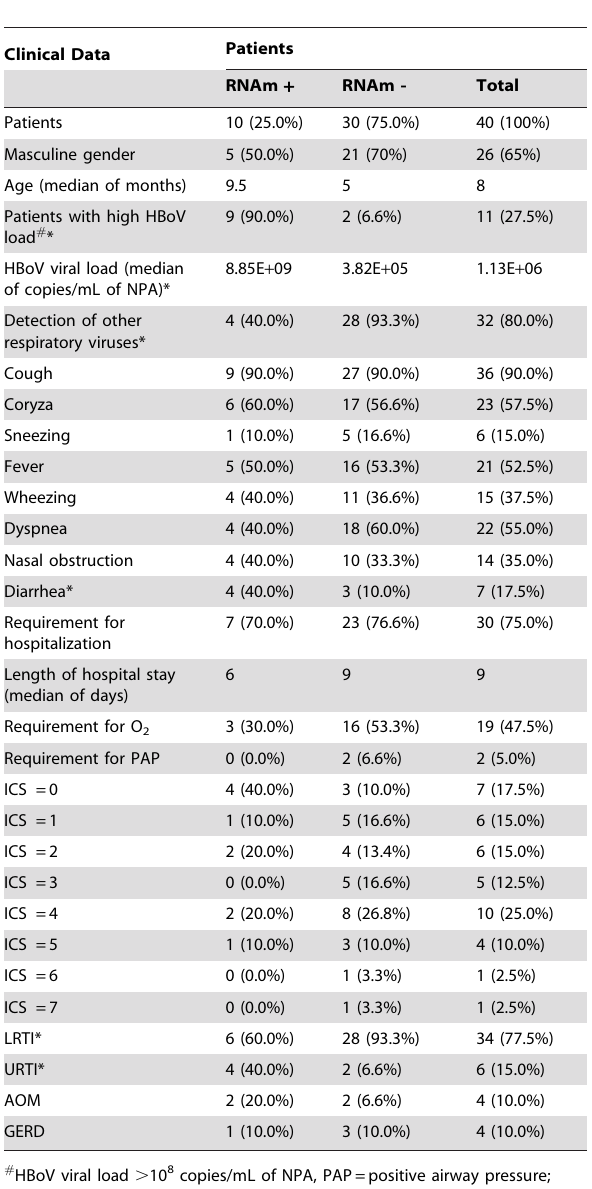
Table 3 . Clinical and demographic data of patients shedding HBoV VP1 mRNA.